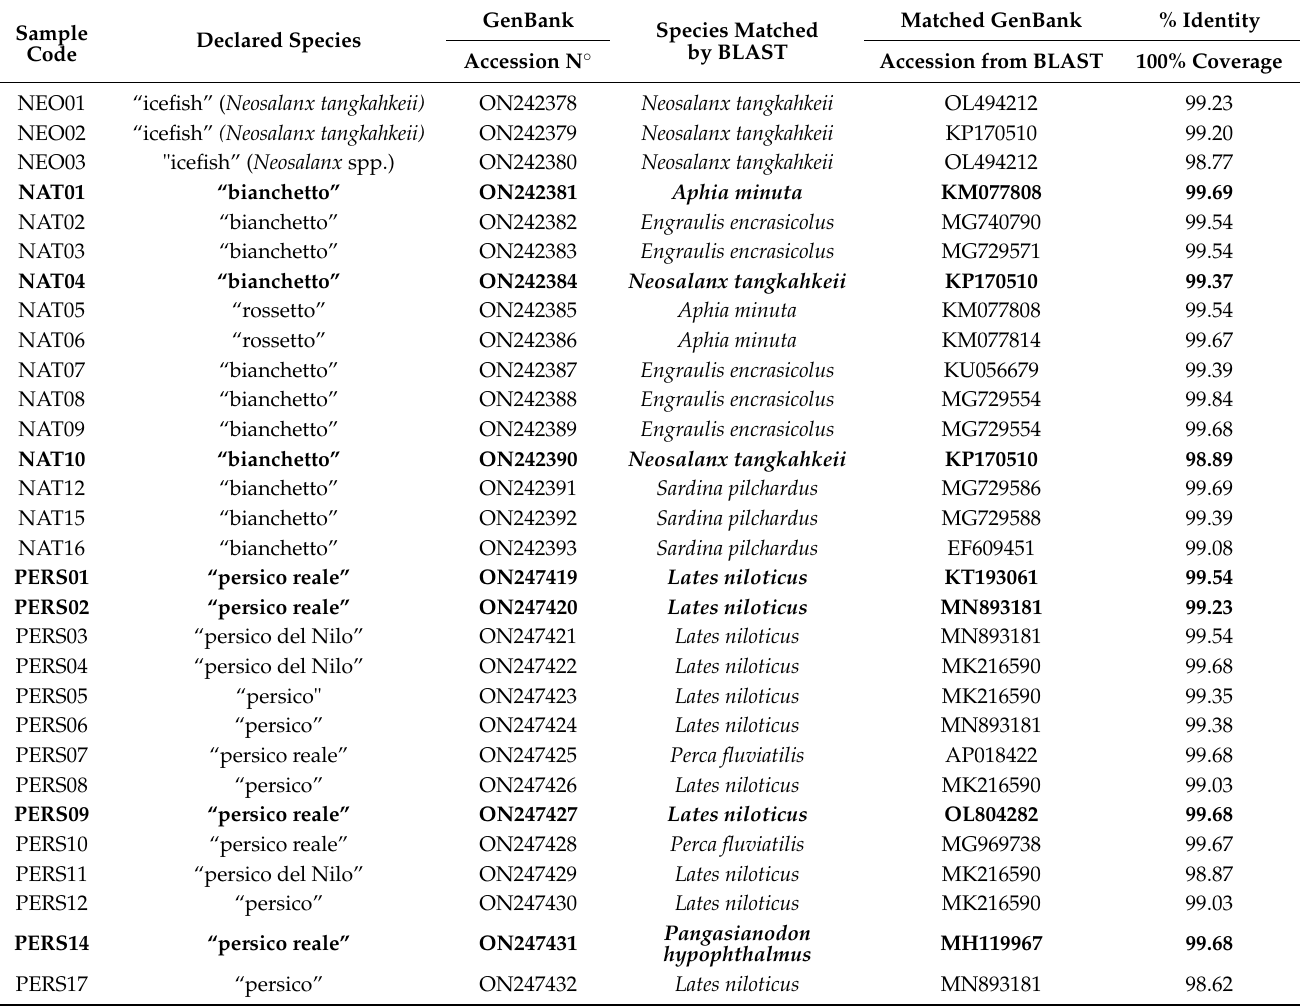
Table 1. Samples examined in this